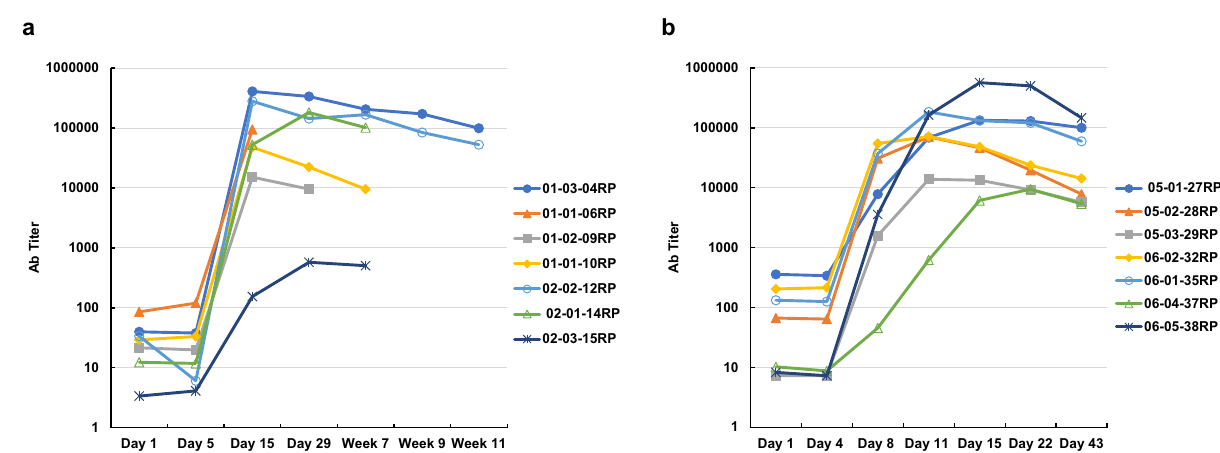
Fig. 1 Titers of entolimod-reactive antibodies determined by ELISA in serum samples collected from cancer patients administered with different doses of entolimod. Antibody titer shown for day 1 is for serum collected prior to the fi rst entolimod injection. a Entolimod administered daily for 5 days (on days 1 – 5) s.c. at a dose of 5 μ g (subjects 01-03-04RP, 01-01-06RP, 01-02-09RP, and 01-01-10RP) or 10 μ g (subjects 02-02-12RP, 02-01-14RP, and 02-03-15RP) per injection per patient. b Entolimod administered i.m. (on day 1) and s.c. (on days 4, 8, and 11) at a dose of 30 μ g (subjects 05-01-27RP, 05-02-28RP,